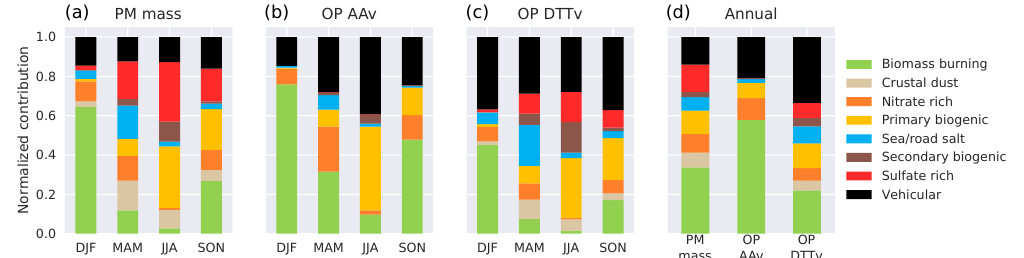
Figure 6. Normalized seasonal contribution of the sources to (a) the PM 10 total mass, (b) the OP AA v and (c) the OP DTT v . DJF is shows the annual normalized contributions of each source to the PM, OP AA v and OP DTT v